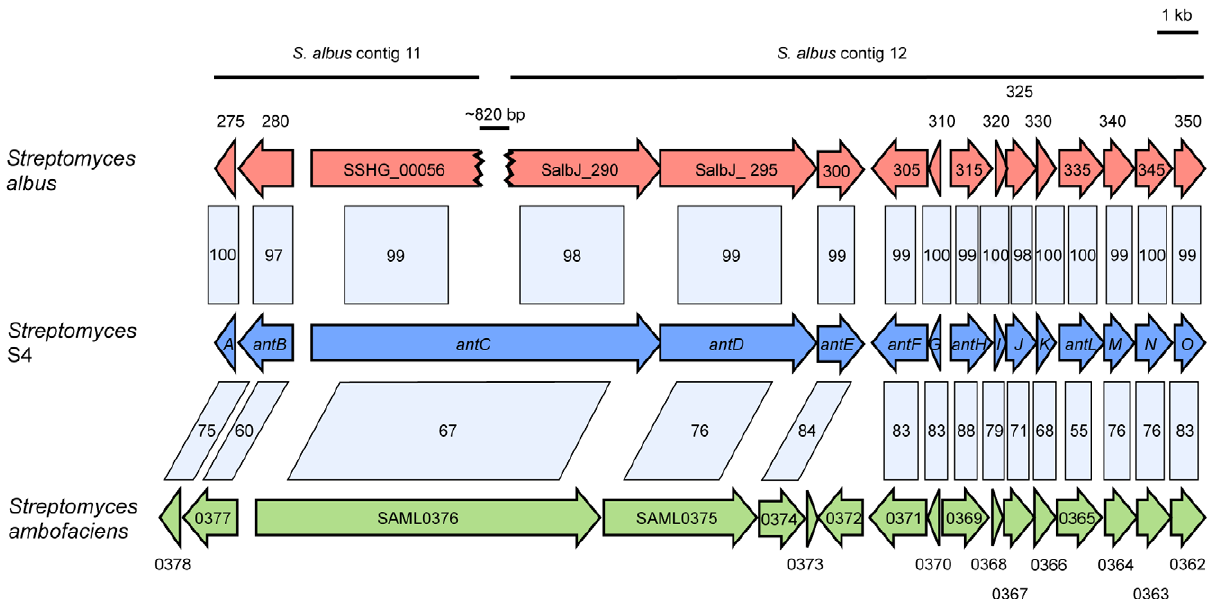
Figure 4. Gene schematic of the Streptomyces S4 antimycin biosynthetic gene cluster and comparison to putative antimycin clusters in Streptomycesalbus and Streptomycesambofaciens . The percent amino acid homology shared between S4 proteins and proteins in S. albus and S. ambofaciens is indicated in the shaded boxes. The draft genomic sequence of S. albus is incomplete and the sequence for the putative antimycin biosynthetic gene cluster is split over contig 11 and contig 12 with an estimated gap of , 820 bp in the antC gene. The Streptomyces S4 antimycin biosynthetic gene cluster is located on scaffold06 at coordinates 81953–106578. The partial genome sequences of Streptomyces S4, S. albus J1074, and S. ambofaciens ATCC 23877 are available under accession numbers CADY00000000, ABYC00000000 and AM238663, respectively. The gene names for S. albus have been shortened to eliminate the first nine numbers of the gene name (e.g. SalbJ_290=SalbJ_010100000290).